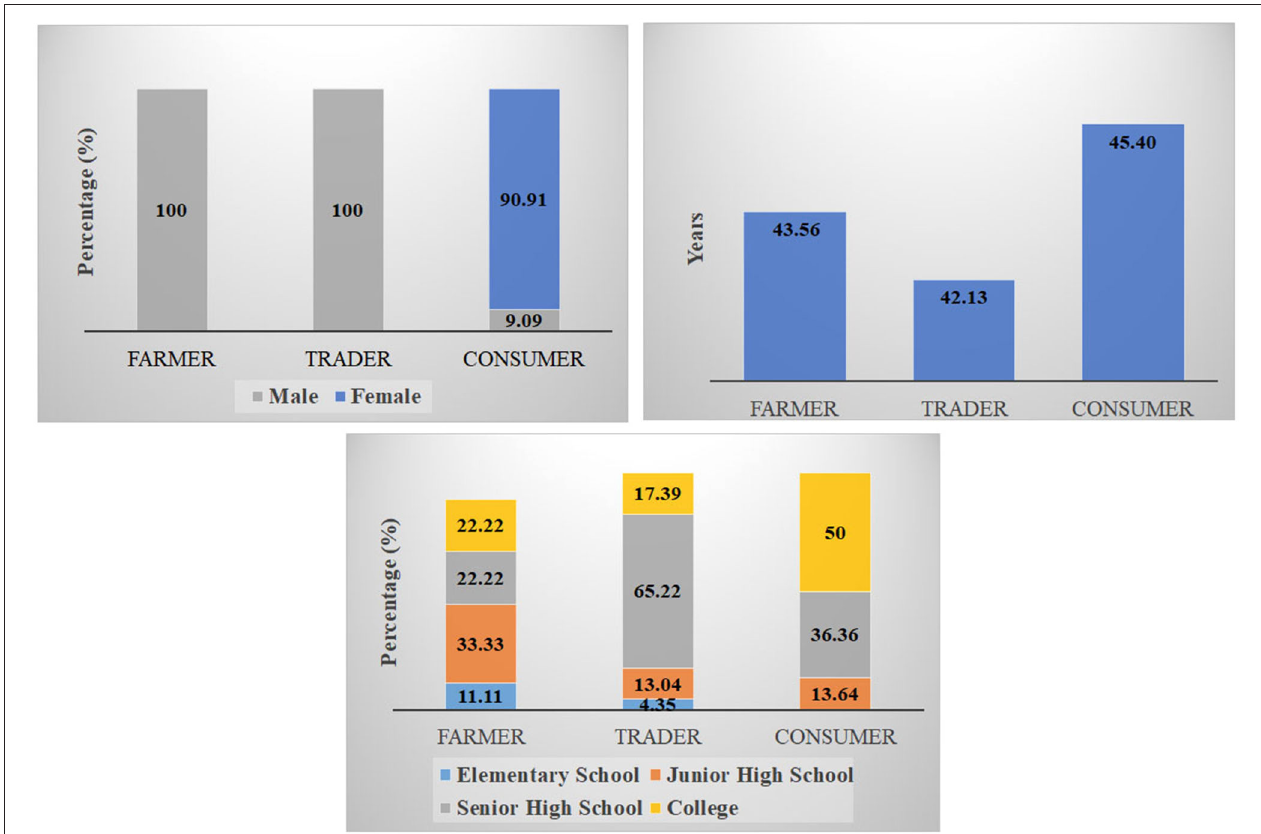
FIGURE 3 | Characteristics of respondents as key actors of Aceh cattle development study.